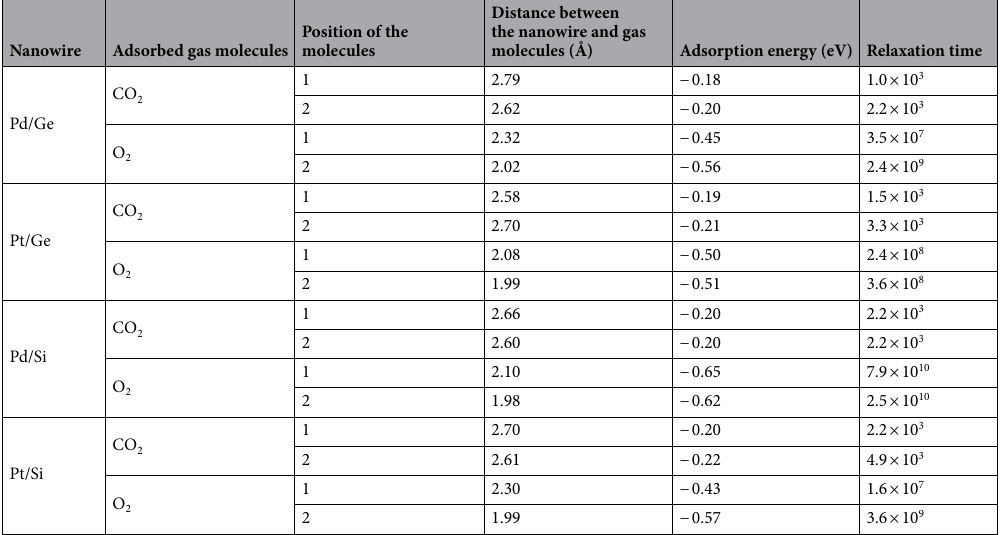
Distance between the nanowire and gas molecules